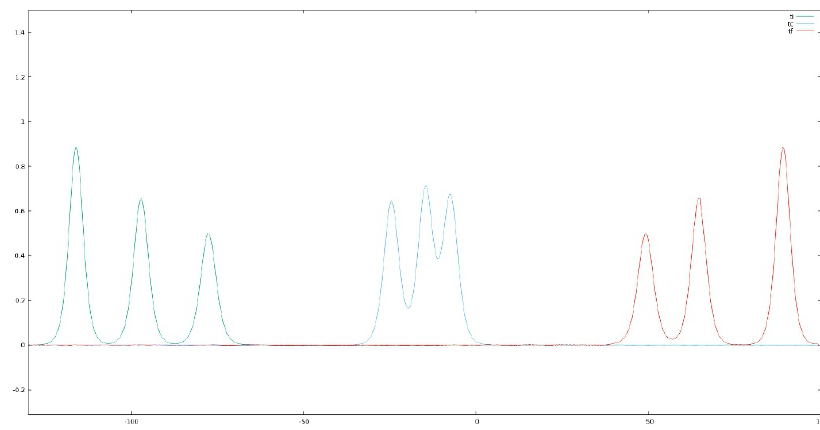
Figure 3 . Numerical simulation of 3-soliton collision for three successive times, t i , before collision (green); t c , collision (blue) and t f , after collision (red); for the parameter values (cid:15) 1 = 1 : 2 ; (cid:15) 2 = 0 : 9 ; (cid:11) = 4 ; k 1 = 0 : 75 ; k 2 = 0 : 71 ; k 3 = 0 : 67 ; a 1 = a 2 = a 3 = 1, such that the initial condition parameters are: (cid:14) 1 = 87 ; (cid:14) 2 = 69 ; (cid:14) 3 = 52 ; t i = 0 and b j = c j = 0 ( j = 1 ; 2 ; 3). LU decomposition method and considered the time steps and spatial grid as (cid:28) = 0 : 0025 and h = 0 : 14, and (cid:28) = 0 : 0045 and h = 0 : 184, for 2-soliton and 3-soliton,